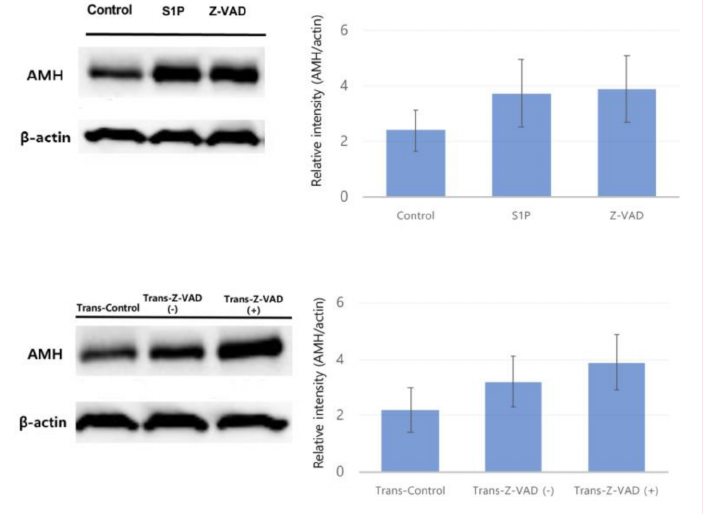
Figure 5. Western blot analysis to evaluate cell apoptosis based on anti-Müllerian hormone produc- tion in frozen–thawed human ovarian tissues and human ovarian tissues after xenotransplantation. Cropped blots are